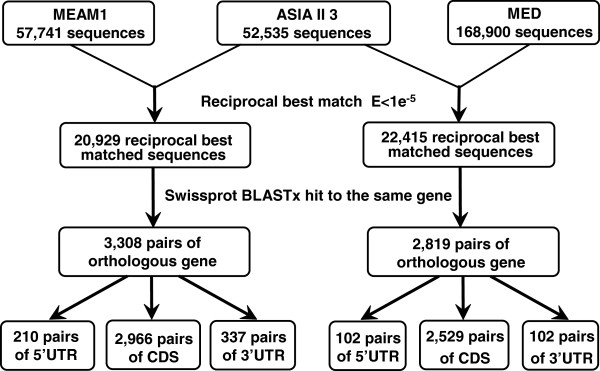
Identification of the orthologous gene pairs between Asia II 3 & MEAM1 and between Asia II 3 & MED. With Megablast, homologous genes were identified using the bidirectional best-hit method. Putatively orthologous gene pairs were further filtered by Blastx against all known proteins in Swissprot database using a threshold of 1×10-5. Coding sequences (CDS) of the orthologous genes were determined based on the annotation of Swissprot Blast hits. After removing the untranslated regions (UTRs), CDS with unexpected codons or shorter than 150 bp were removed. The numbers of gene pairs obtained in each step are shown in the boxes. Left: Asia II 3 & MEAM1; Right: Asia II 3 & MED.